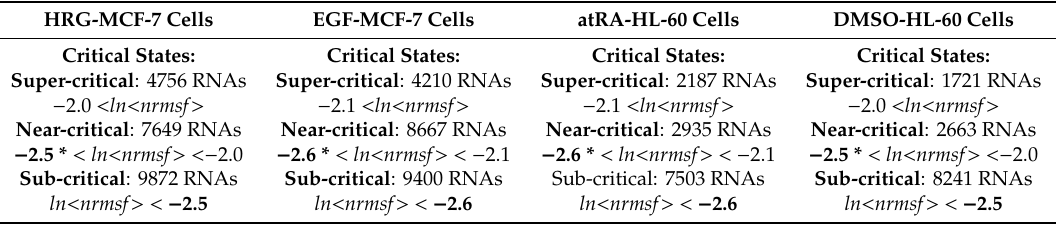
Table 2. Local critical states of cell-population genome expression. The boundaries of critical states with the number of mRNAs are given for HRG- and EGF-stimulated MCF-7 cells, atRA- and DMSO-stimulated HL-60 cells (from left to right column, respectively), where the bold black value corresponds to the ln < nrmsf > value of the CP. * CP exits at the boundary between the near- and the sub-critical